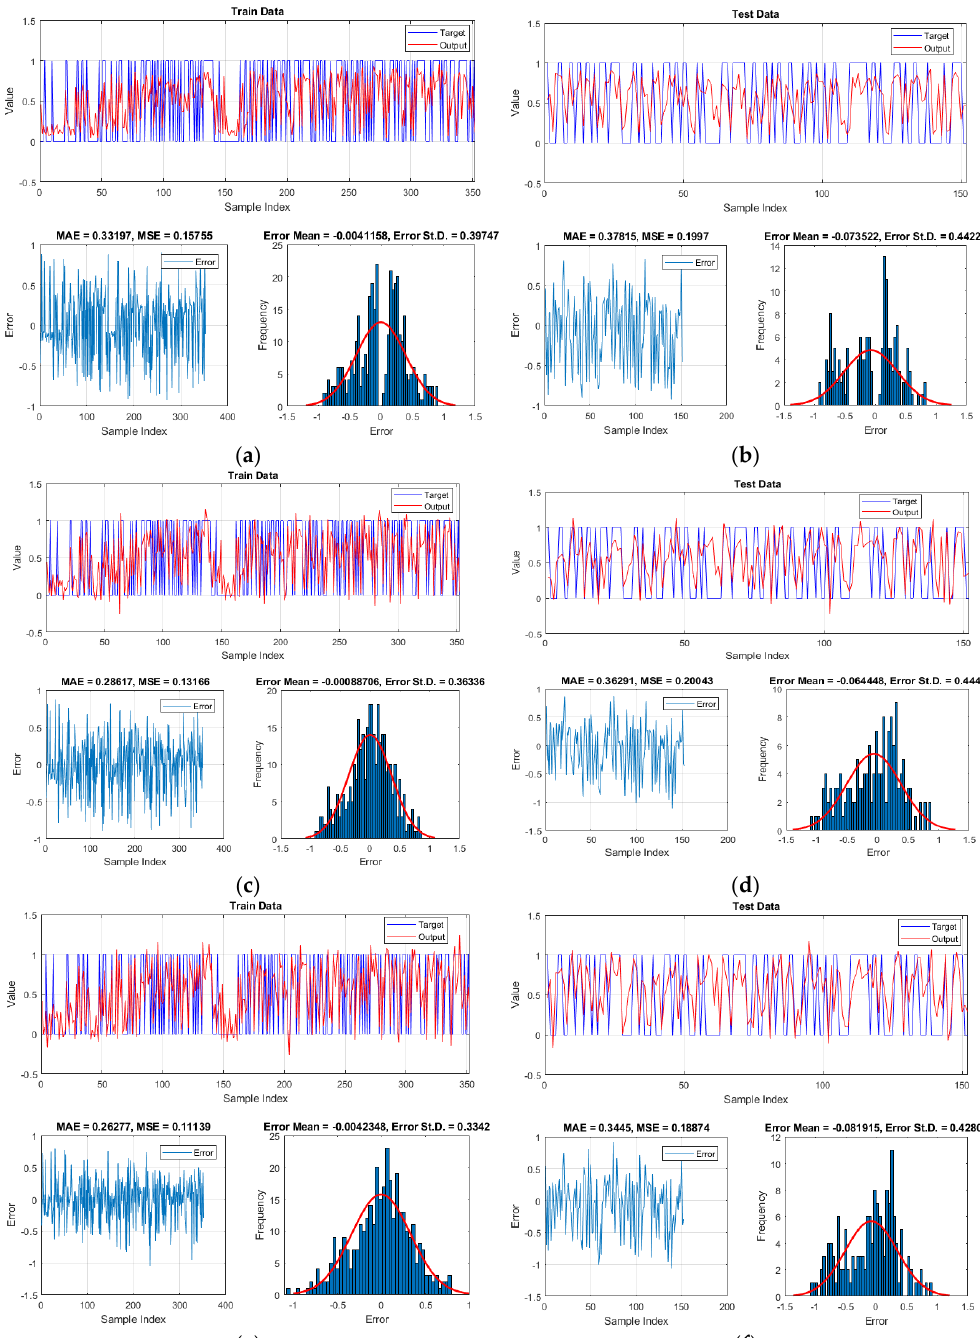
Figure 12. The results obtained for ( a , b ) MLP, ( c , d ) GWO-MLP and ( e , f ) BBO-MLP predictions, respectively for the training and testing samples.